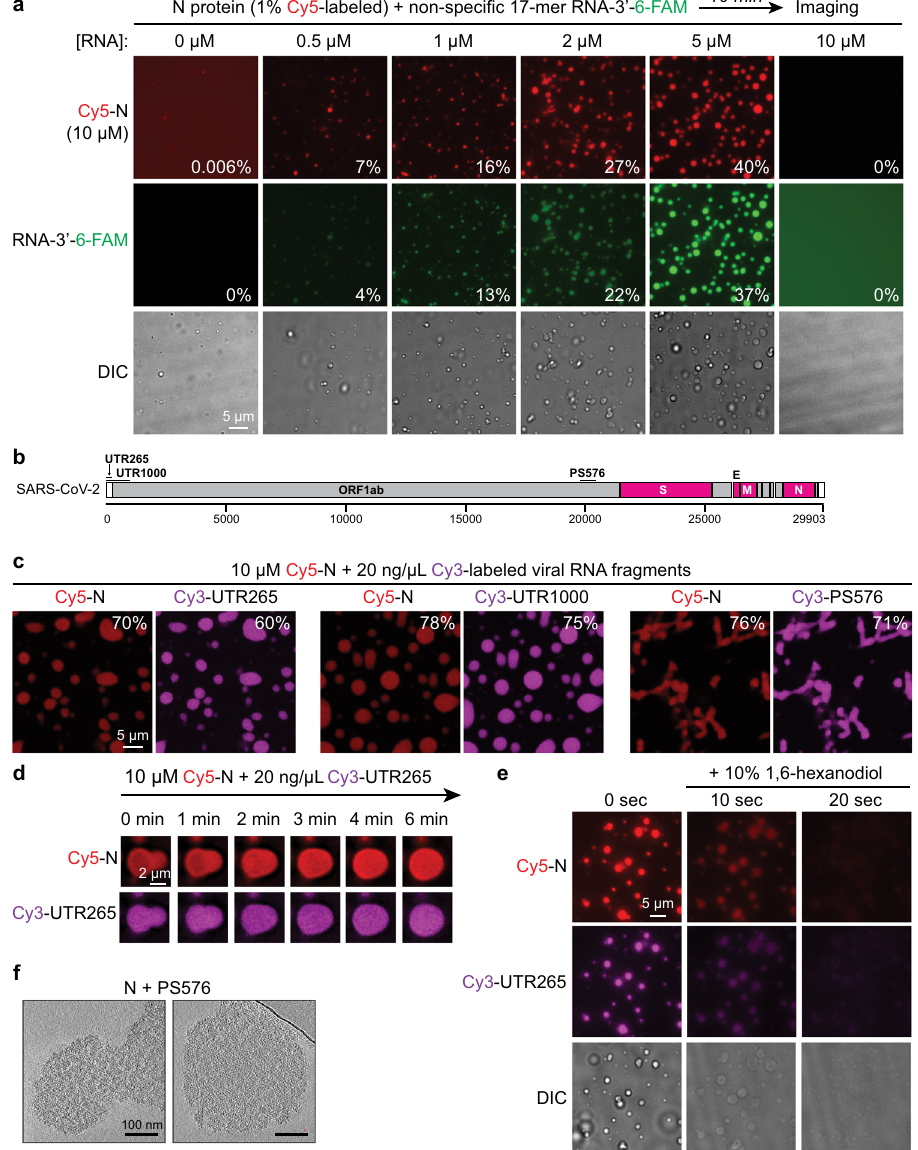
Fig. 1 N protein undergoes phase separation with RNA. a Fluorescence and DIC images of phase separation of N protein (1% N-terminal Cy5-labeled N protein) with a 3 ′ 6-FAM-labeled 17-mer ssRNA. Scale bar, 5 µ m. Percentage values indicate the percentage of total RNA or protein fl uorescence within condensates (see “ Methods ” section). See Supplementary Fig. 1a for N protein phase separation in the absence of added RNA. b Schematic of SARS-CoV-2 viral genome, showing the locations of four structural protein genes (pink) and three viral genome fragments used in this study (Supplementary Table 1). c Fluorescence images of phase-separated condensates formed by N protein with viral RNA fragments. Scale bar, 5 µ m. d Fluorescence images of a representative fusion event of N + RNA condensates. Events were observed in 20 min after initial mixing. e Dissolution of N + RNA condensates by addition of 1,6-hexanediol. f Tomographic slice from a cryo-electron tomography reconstruction of N + RNA condensates (10 µ M N protein plus 20 ng/ µ L PS576 RNA). Scale bar, 100 nm. See Supplementary Fig. 1f, g for power spectrum analysis of tomographic protein with high af fi nity 44,45 ; (2) UTR1000, the fi rst 1000 bases derived RNAs suggests that the viral packaging signal may of the viral genome that includes the 5 ′ -UTR and part of the interact differently with the N protein than nonspeci fi c RNA (see “ Discussion ” section). These condensates showed reentrant phase ORF1ab gene; and (3) PS576, a 576-nt sequence located near the end of the ORF1ab gene (nt 19786 – 20361) corresponding to the separation behavior (Supplementary Fig. 1c), grew over time putative packaging signal for SARS-CoV viral RNA 46,47 . We (Supplementary Fig. 1d), and displayed classical behaviors, such found that addition of 20 ng/µL (~62 µM nucleotide) viral RNA as fusion of droplets (Fig. 1d) and dissolution upon addition of fragments containing the 5 ′ -UTR to 10 µM N protein induced the 10% 1,6-hexanediol, an organic solvent that disrupts a wide range formation of round condensates (Fig. 1c). In contrast, addition of of biomolecular condensates by reducing the hydrophobic the PS576 fragment caused the formation of more amorphous effect 48 – 50 (Fig. 1e). Cryo-ET of N protein + RNA condensates structures resembling a fi brillar network (Fig. 1c). The distinct revealed well-de fi ned texture suggestive of internal order, which structures formed with PS576 compared to 17-mer RNA or UTR- was also observed by super-resolution light microscopy (Fig. 1f